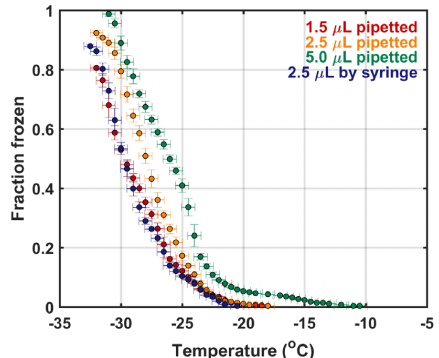
Figure 5. Freezing spectra for the control experiments conducted to characterize the drop size chosen for DFCP analysis. Results in- cluded here are tests evaluating pipetted versus syringe-aliquoted drops and at different volumes. Error bars for the y and x axes cor- respond to standard deviation per 0.5 ◦ C bin and temperature probe– plate versus drop variability standard deviation, respectively. Spec- tra that do not reach a frozen fraction of 1 indicates not all drops froze at the lower limit of the